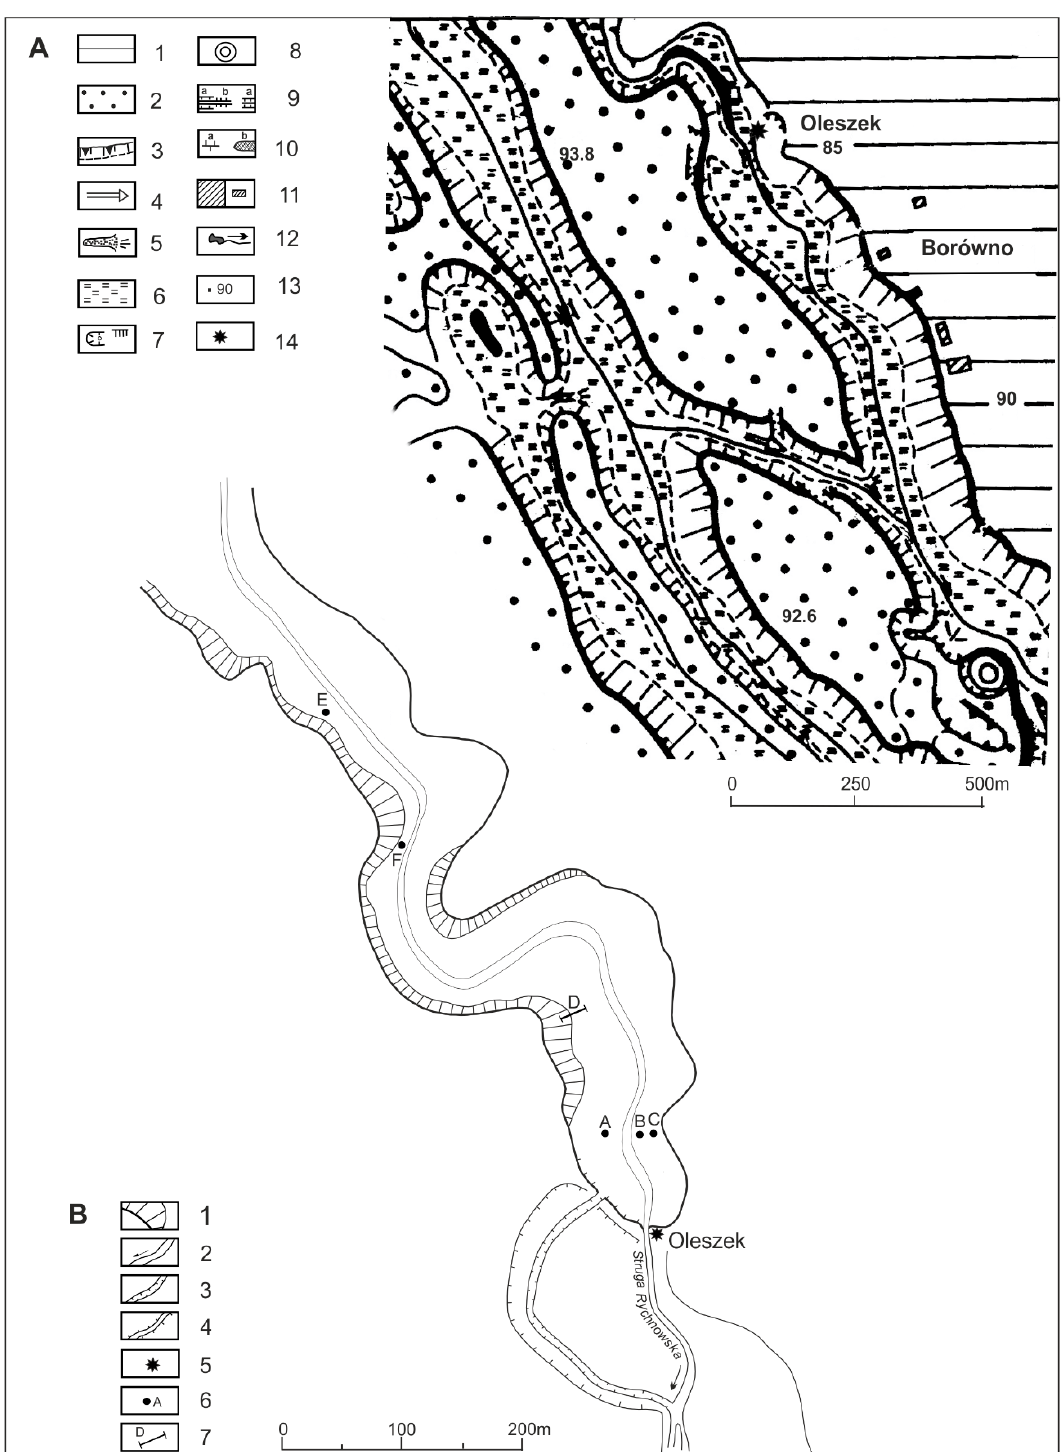
Figure 4. The Oleszek site on Struga Rychnowska. Notation: ( A ) The geomorphological map: 1—flat moraine plateau, 2—outwash, 3—subglacial channels, 4—melt water valleys, 5—Holocene V-shaped valleys of the gully type, 6—biogenic plains, mainly peat, 8—mediaeval stronghold, 9—road incisions (a) and embankments (b), 10—dykes (a) and dams (b), 11—farmsteads, 12—water reservoirs and watercourses, 13—absolute heights, 13—watermill location; ( B ) 1—break and gentle slope of mill pond basin, 2—watercourse, 3—bypass channel, 4—dyke, 5—watermill locations, 6—investigated profiles, 7—profile line.